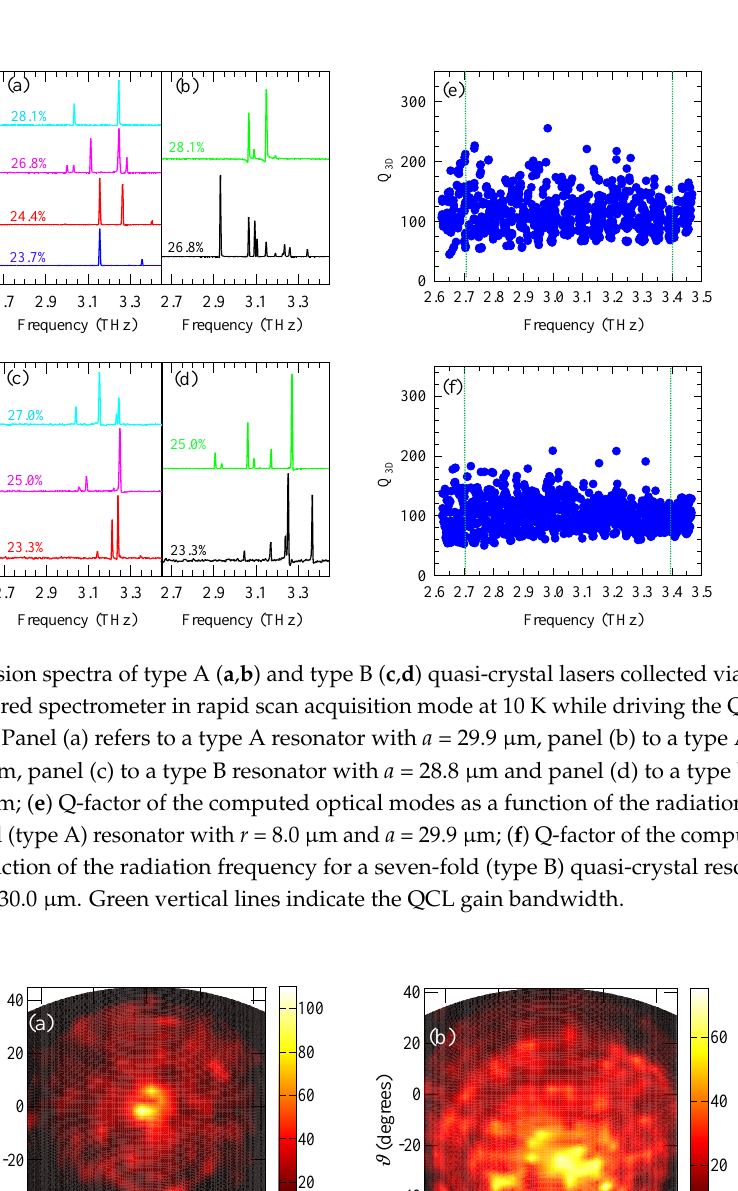
Figure 7. ( a , b ) Far-field emission patterns of the ( a ) type A (FF = 26.8%, a = 32.5 μm) and ( b ) type B (FF = 25%, a = 30 μm) obtained by scanning a pyroelectric detector at a distance of about 5 cm distance from the device surface.